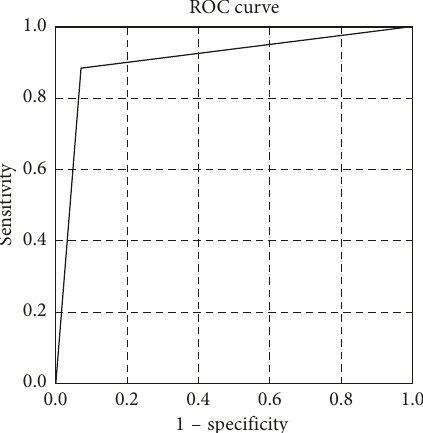
Figure 2: Receiver operating characteristic (ROC) curve based on a cutoff LRINEC-OC score of 6 in predicting the presence of necrotizing fasciitis. Area under the curve for our model is 0.909. ≥